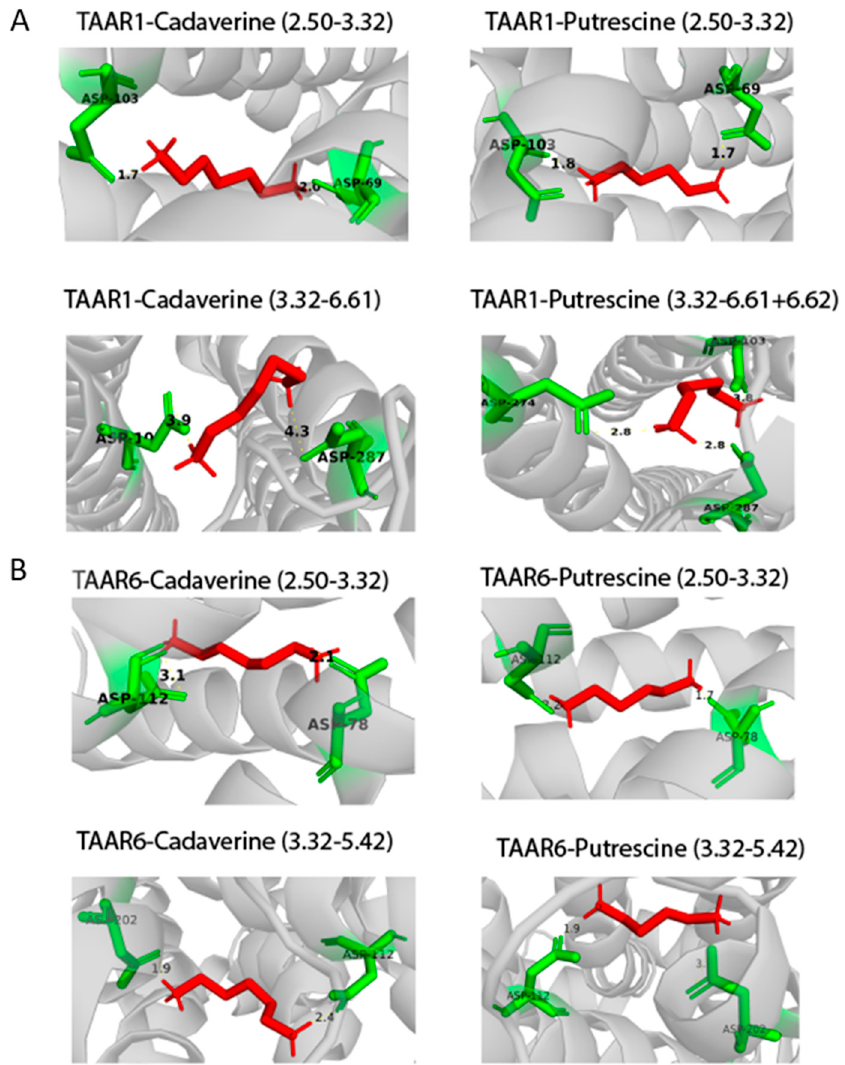
Figure 7. ( A ) Putative orthosteric binding sites of TAAR1 to aliphatic ligands. Cadaverine and putrescine can only bind to one orthosteric site of the Asp 2.50 / 3.32 TAAR1 receptor. ( B ) Putative orthosteric binding sites of TAAR6 to aliphatic ligands. Cadaverine and putrescine can bind to two orthosteric sites, Asp 2.50 / 3.32 and Asp 3.32 / 5.42 of the TAAR6 receptor. All crystal structures were visualized with PyMol.